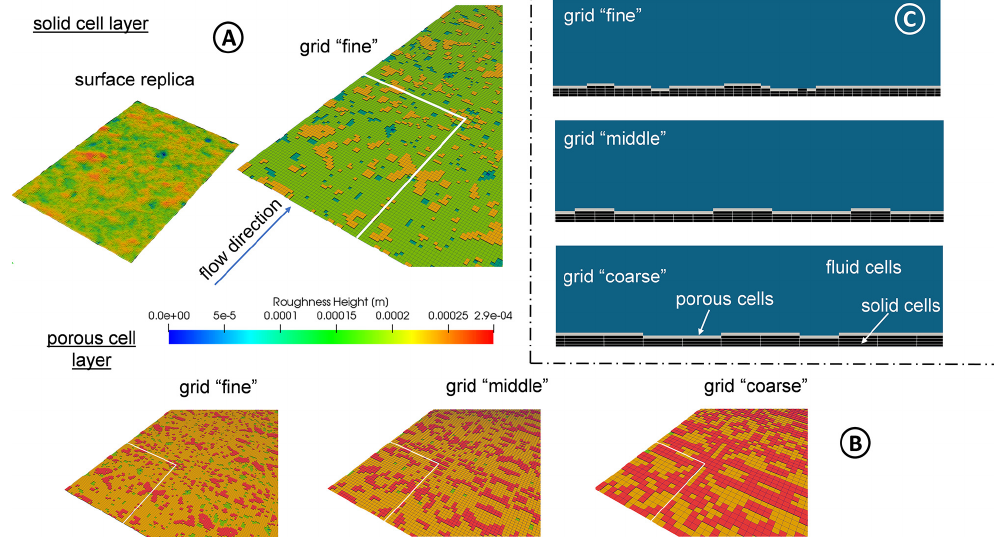
Figure 13. Illustration of the roughness zone in the DPM simulations with the cast iron surface. ( A ) Roughness surface of the replica (Section 2.1) and the solid cell layer of the DPM simulation with the finest grid. ( B ) Comparison of the porous cell zone between the three applied grids. ( C ) Picture detail with fluid, solid and porous cells for the three grids in a planar cut